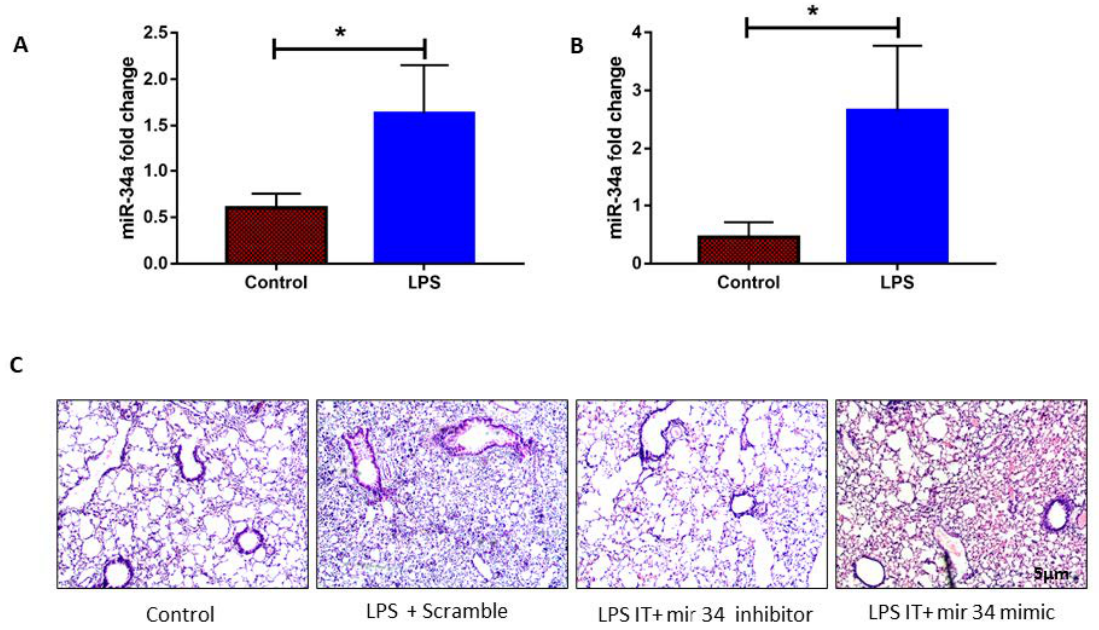
Figure 2. Lipopolysaccharides (LPS) induced miR-34a induction increases lung injury. ( A ) miR-34a expression was induced in mice lung after 24 h of intra-tracheal administration (10 mcg/mice) of LPS. ( B ) Treatment of LPS in RAW264.7 cell line also induced miR-34a expression after 16 h. ( C ) Mice were treated with LPS along with miR-34a inhibitor, mimics, and scrambled, lung tissues were stained with Hematoxyline & Eosine, and histology was seen in the light microscope. Test of significance was done by Student t-test. * p < 0.05, (four animals were